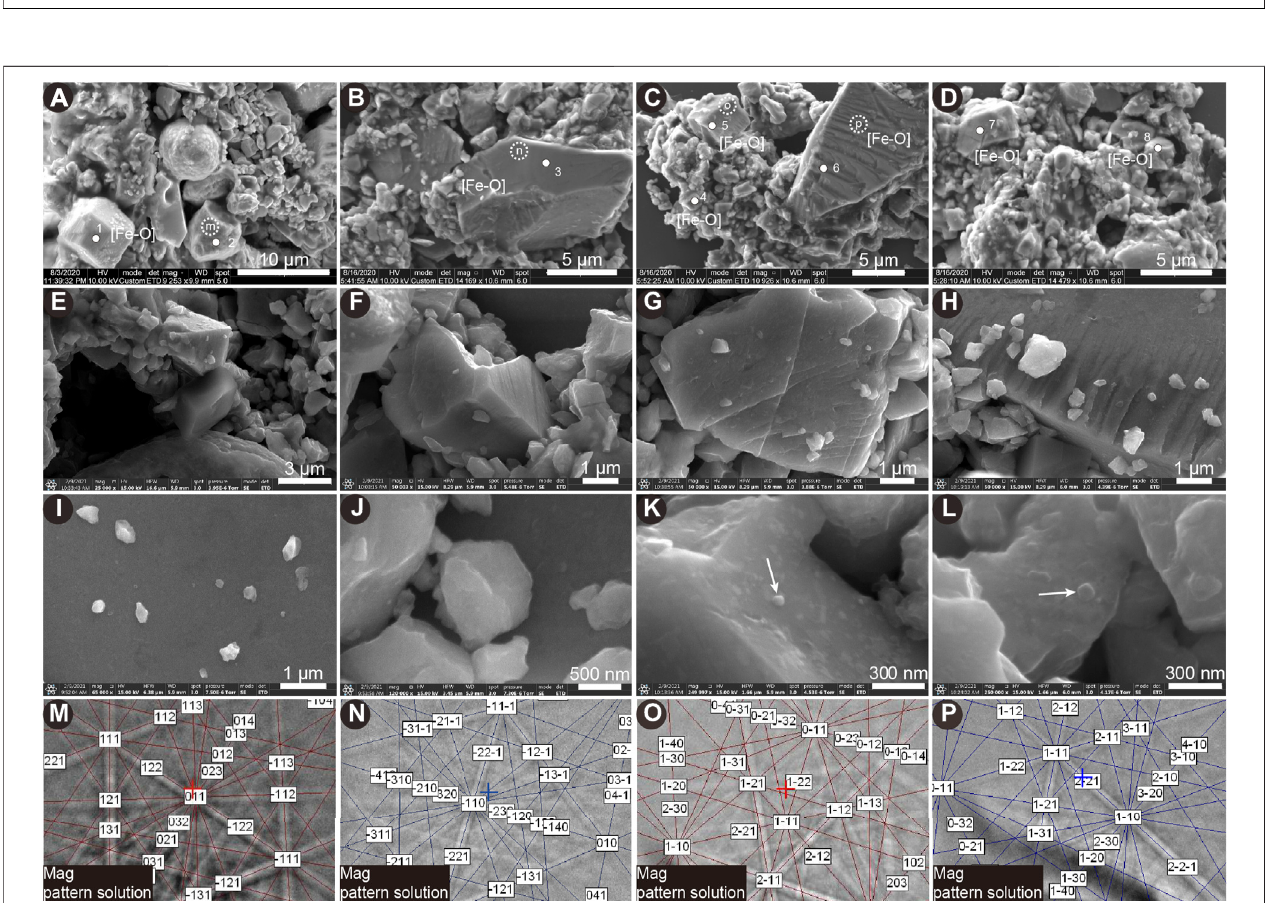
FIGURE 4 | (A – L) Secondary-electron SEM images of magnetic extracts in limestones of the Zongpu Formation. (M,P) EBSPs solution of iron oxides correspondingtothewhitecirclesindicatedin (A – C) .Zone axes arelabeled using Millerindices.Note thewhitecircleareas are notasaccurateasthatwasshown inthe images,becauseofthelowresolutionofSEMduringEBSDanalyses.Whitearrowsin (K,L) indicatethepossibleoccurrenceofbiogenicmagnetite.Whitedotsrepresent the EDS spots as shown in Supplementary Figure S3 . [Fe-O] (cid:1) iron oxides; Mag (cid:1) magnetite.